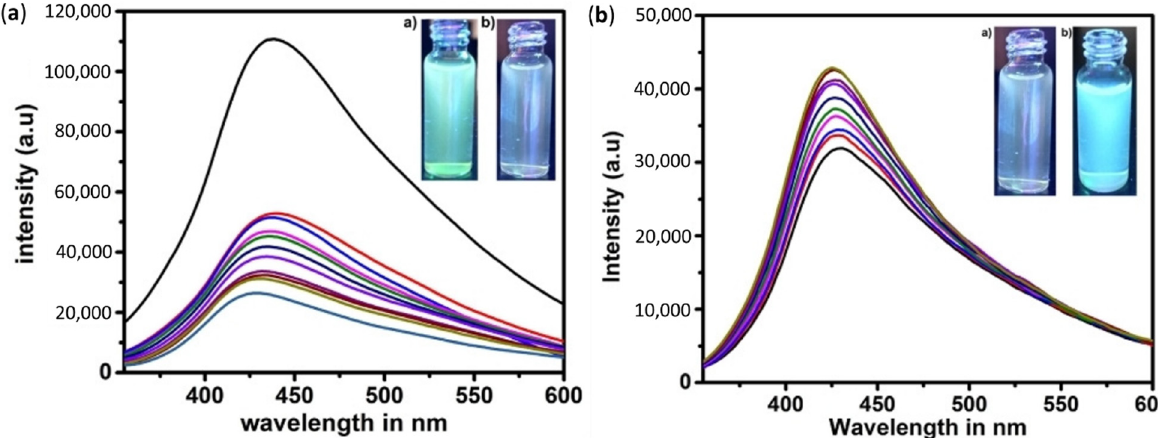
Figure 21. ( a ) Fluorescence spectra of GQDs and complex GQD-DOAZOC1. Inset is the visual fluorescence of (a) GQDs (b) GQD-DOAZOC1 complex. ( b ) Fluorescence spectra of GQD-DOAZOC1-CARBOFURAN complex. Inset is the visual fluorescence of (a) GQD-DOAZOC1 (b) GQD-DOAZOC1-CARBOFURAN complex. (Reprinted with permission from [96]; Copyright 2017, John Wiley and Sons).